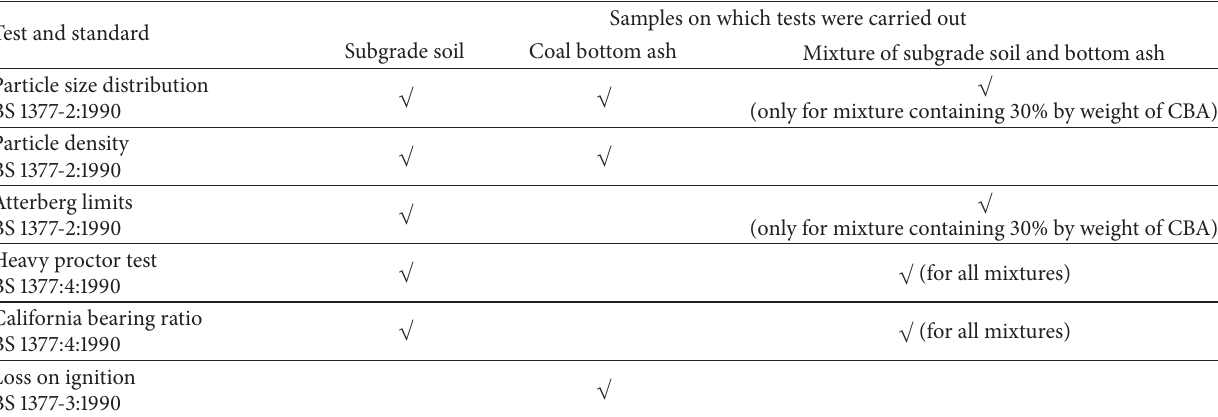
Table 1: Laboratory tests carried out and standards